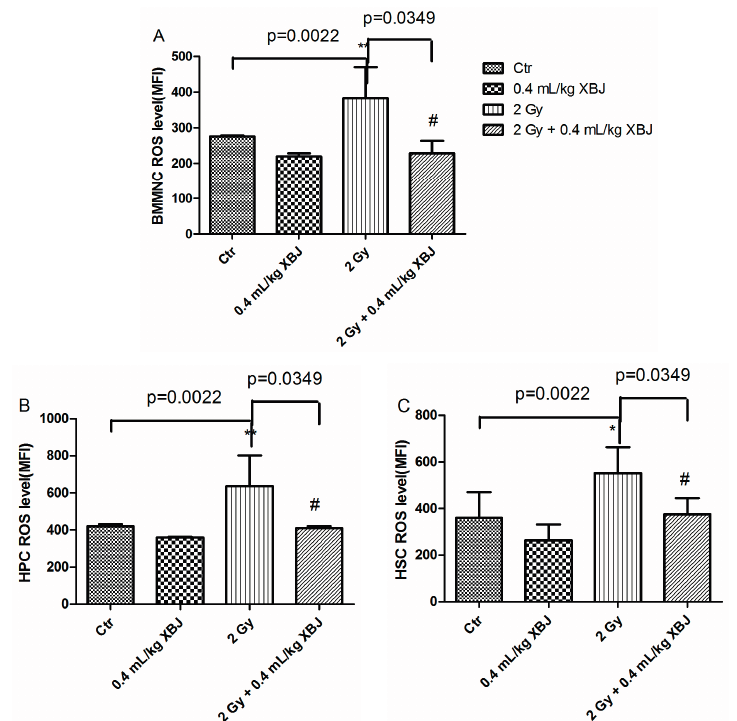
Figure 5. ROS levels were decreased by XBJ. ( A ) The ROS levels of BMMNCs; ( B ) the ROS levels of HPCs; ( C ) the ROS levels of HSCs. * p < 0.05, ** p < 0.01 vs . the control group; # p < 0.05 vs . the IR